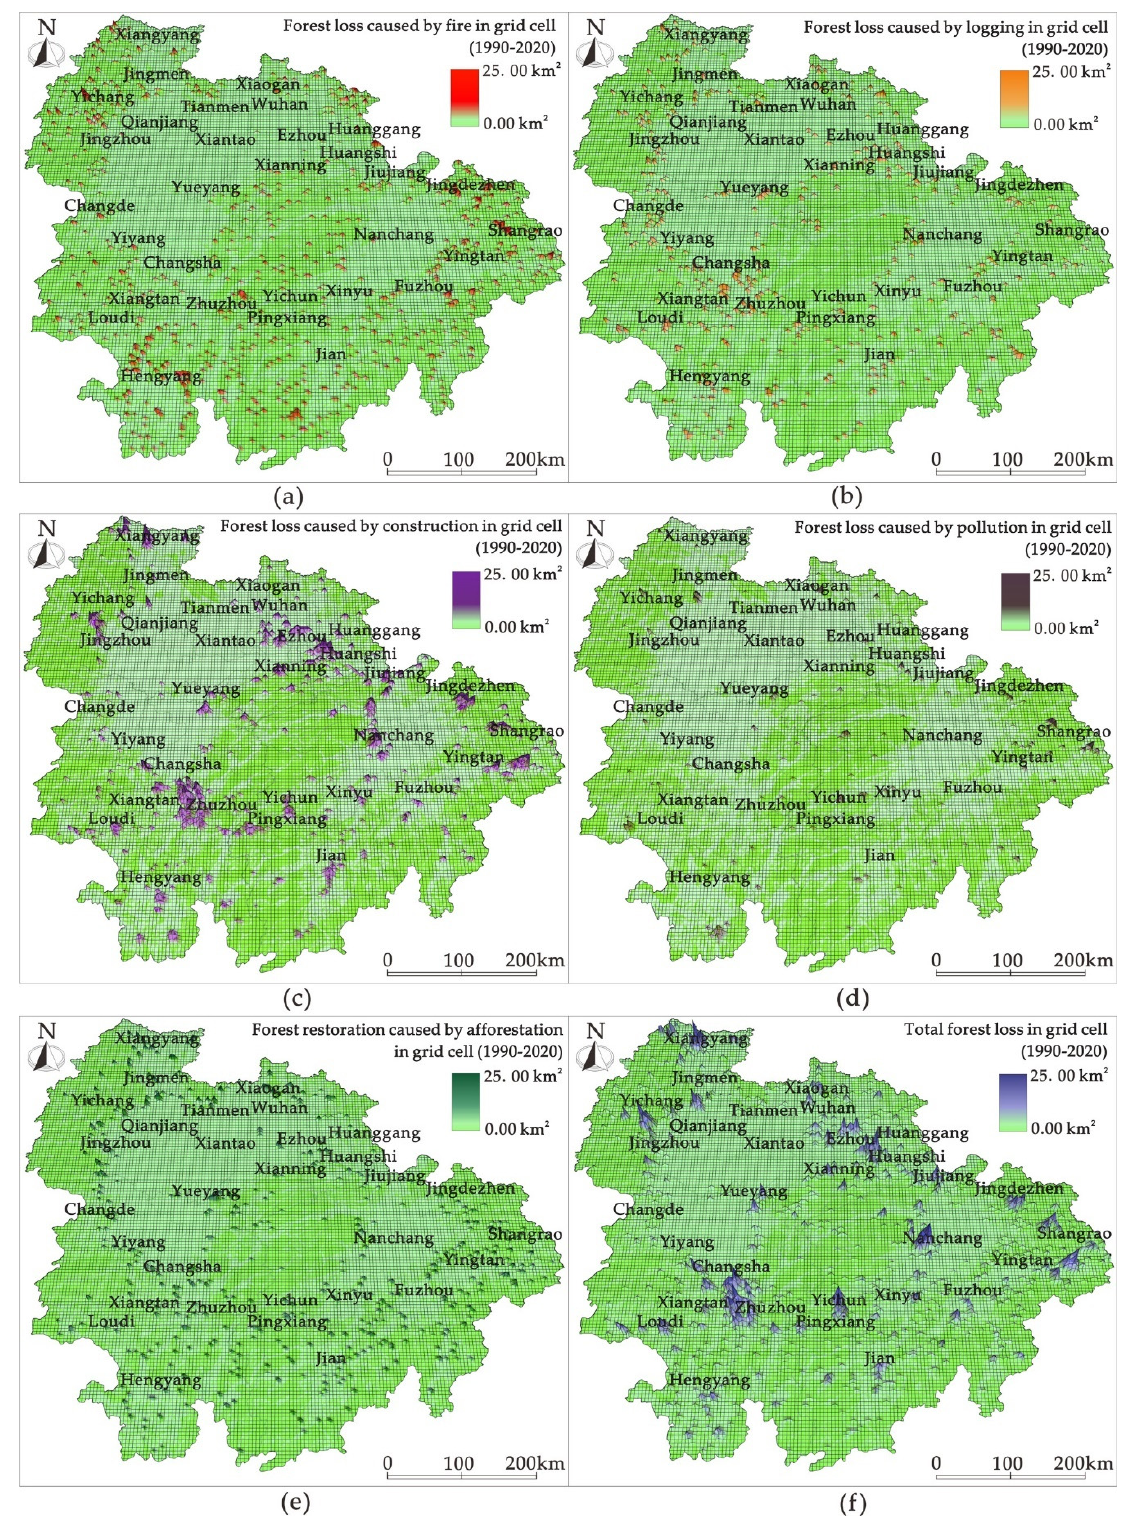
Figure 6. Spatial distribution of forest loss and afforestation: ( a ) spatial forest loss caused by fire; ( b ) spatial forest loss caused by logging; ( c ) spatial forest loss caused by construction; ( d ) spatial forest loss caused by pollution; ( e ) spatial forest restoration caused by afforestation; ( f ) spatial distribution of total forest loss.